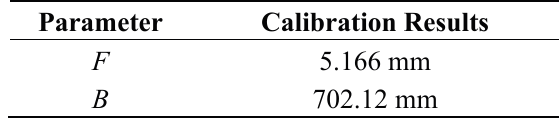
Table 5. Results of the calibration